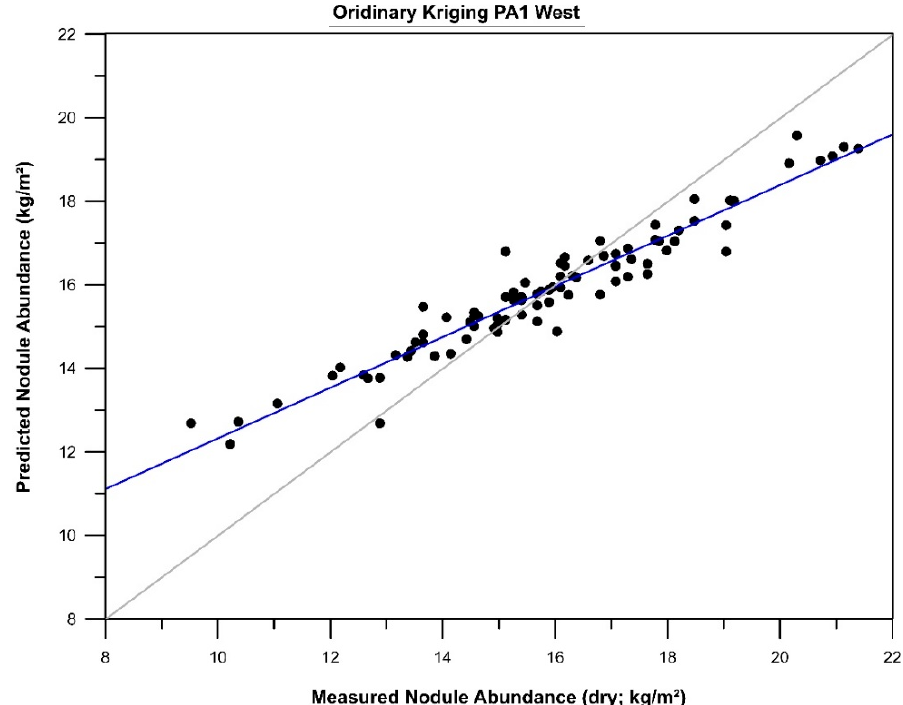
Figure 17. Correlation between measured and predicted nodule abundance in PA1-West. The RMS error is 1.04 kg/m 2 at a predicted mean value of 15.9 kg/m 2 that amounts to a relative prediction error of 13%. The deviation from the 1:1 line may be caused by a slight trend in the original data, which could not be